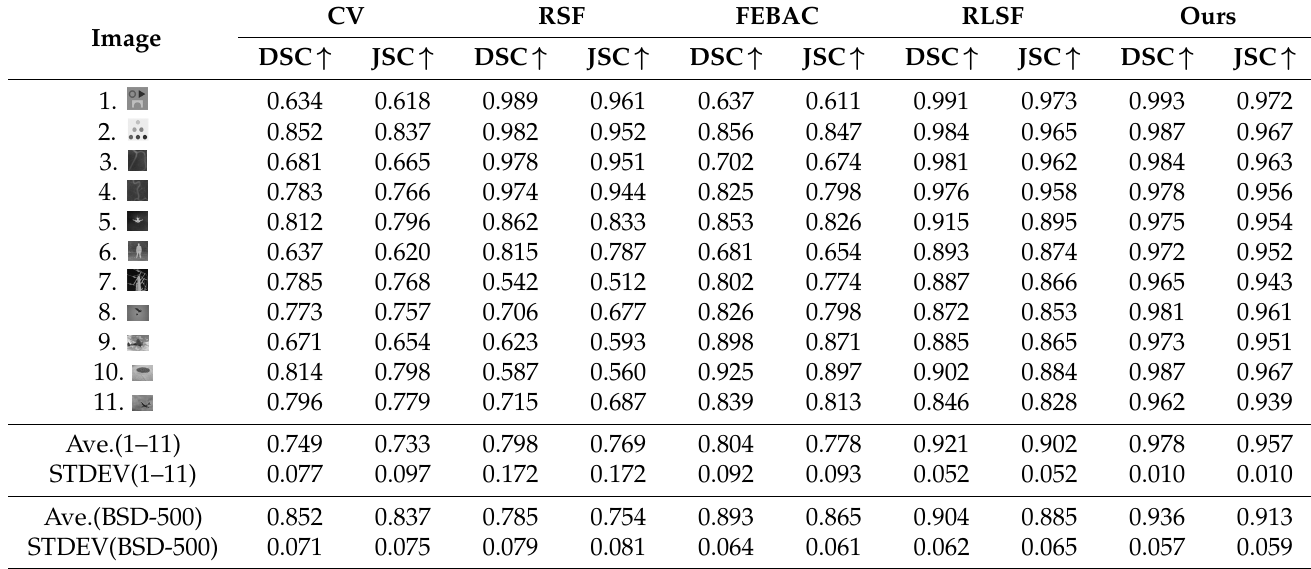
Table 1. The quantitative experiments with five methods on the 11 images and BSD-500